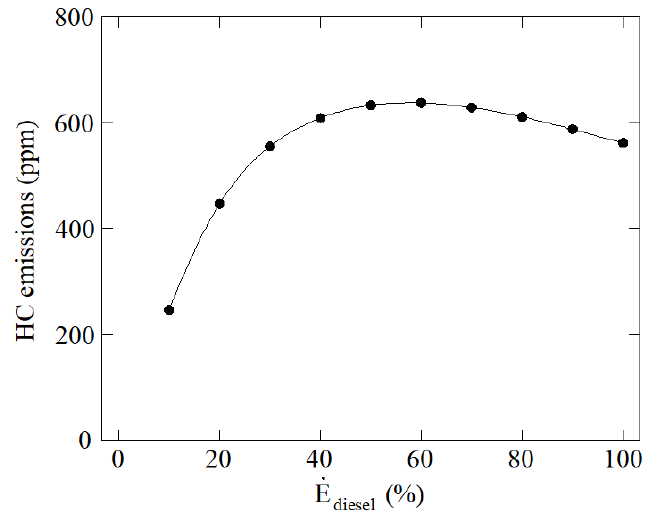
Figure 7. HC emissions against the power contribution from diesel fuel.